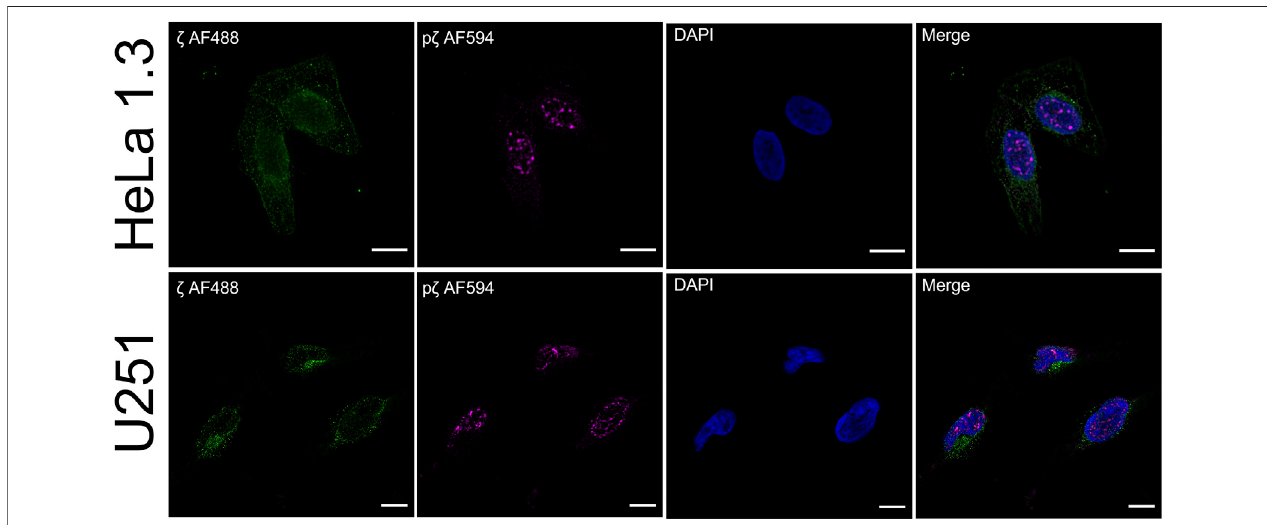
FIGURE 6 | Phosphorylation of 14-3-3 ζ shifts its localization from the cytosol to the nucleus. Endogenous expression levels of ζ (green) and p ζ (magenta) were analyzed using immuno fl uorescence in HeLa 1.3 cells and U251 cells. Immunostaining was performed using speci fi c primary anti-14-3-3 ζ and anti-14-3-3 ζ pS58 antibodies, and corresponding AF-conjugated secondary antibodies. Nuclei were stained with DAPI (blue). Scale bars represent 10 µm. Negative controls were performed to exclude nonspeci fi c binding of primary antibodies (Supplementary Figure S6)